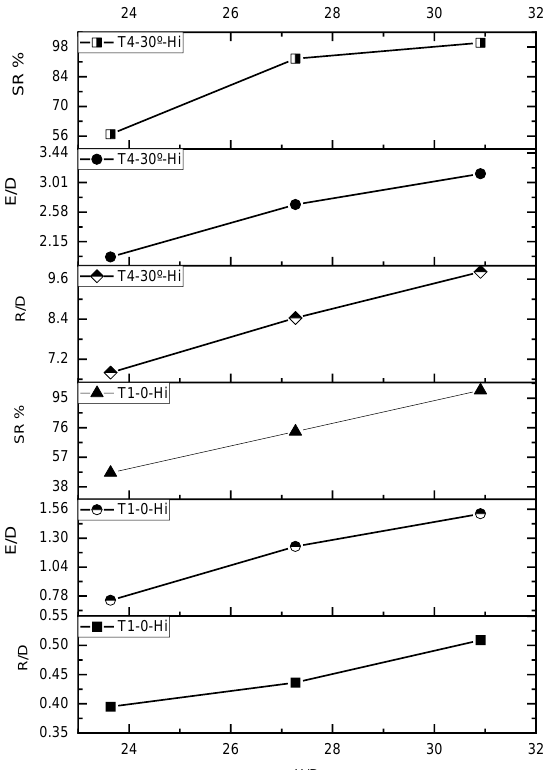
Figure 10. Effect of effective head on the scour hole properties.